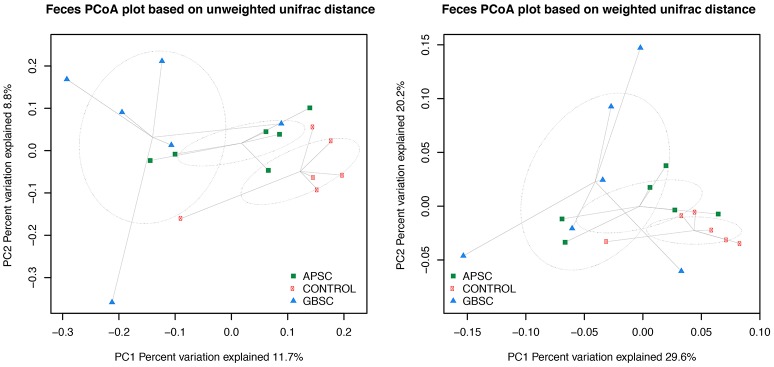
Two-dimensional PCoA plots based on the unweighted and weighted UniFrac distance matrix illustrates variation in fecal bacterial communities as affected by different subacute ruminal acidosis (SARA) challenge conditions. The ellipses were drawn with standard errors of the points at 0.95 confidence limit. Labels are placed at means centers of each site and are linked to each sample of the corresponding site. Abbreviations in figure: APSC, alfalfa-pellet SARA challenge; GBSC, grain-based SARA challenge. Significance levels unweighted analysis, APSC vs. Control P = 0.01; GBSC vs. Control P < 0.01; GBSC vs. APSC P = 0.15. Significance levels weighted analysis, APSC vs. Control P = 0.05; GBSC vs. Control P < 0.01; GBSC vs. APSC P = 0.28.